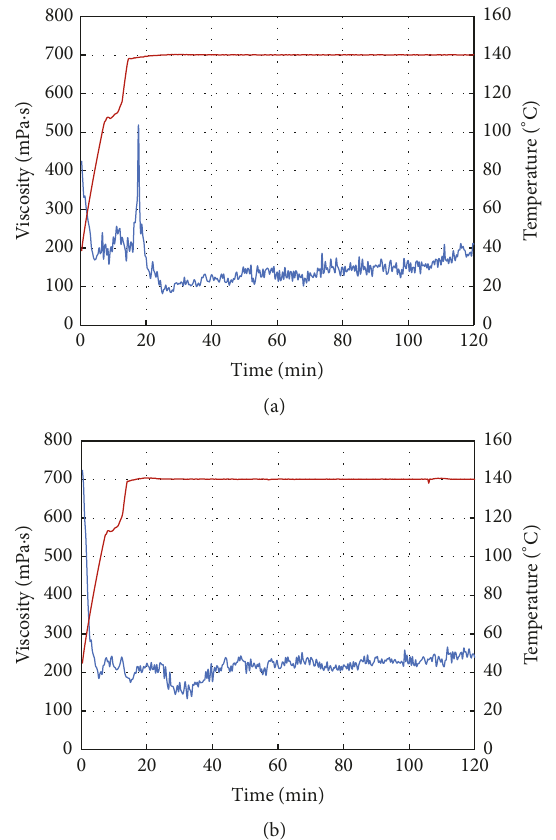
Figure 11: Comparison of shear resistance of the cross-linked guar synthesized using the original formulation (a) or using the recycling formulation (b) under 140 ∘